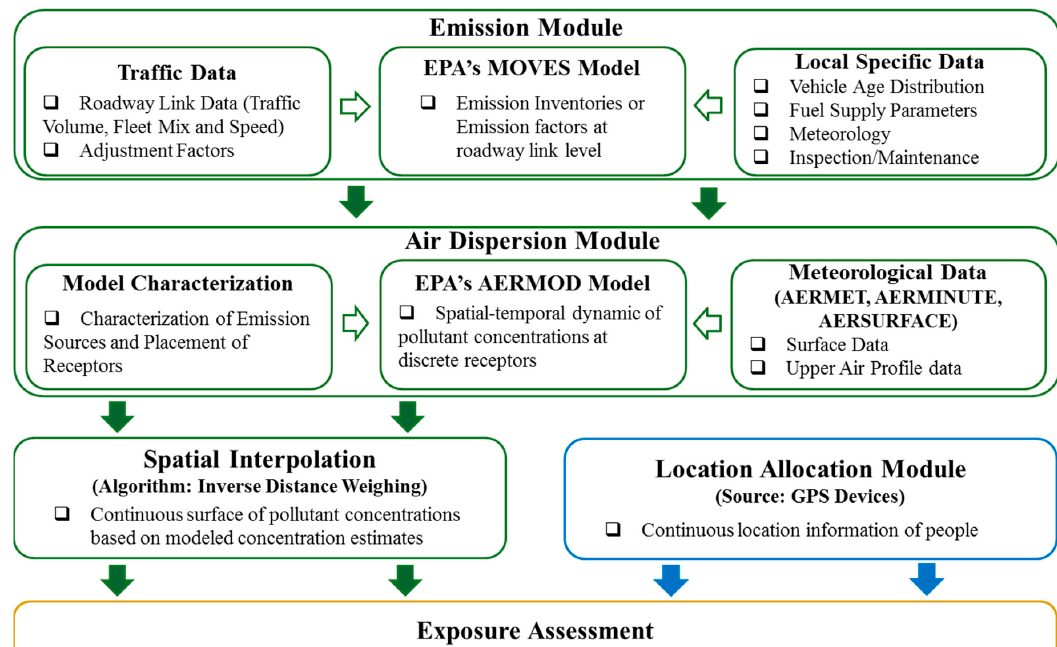
Figure 1. Overall modeling framework.